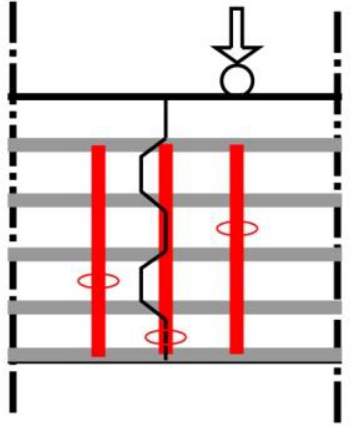
Figure 10. Location of cracks close to the shear keys in the segmental beam.